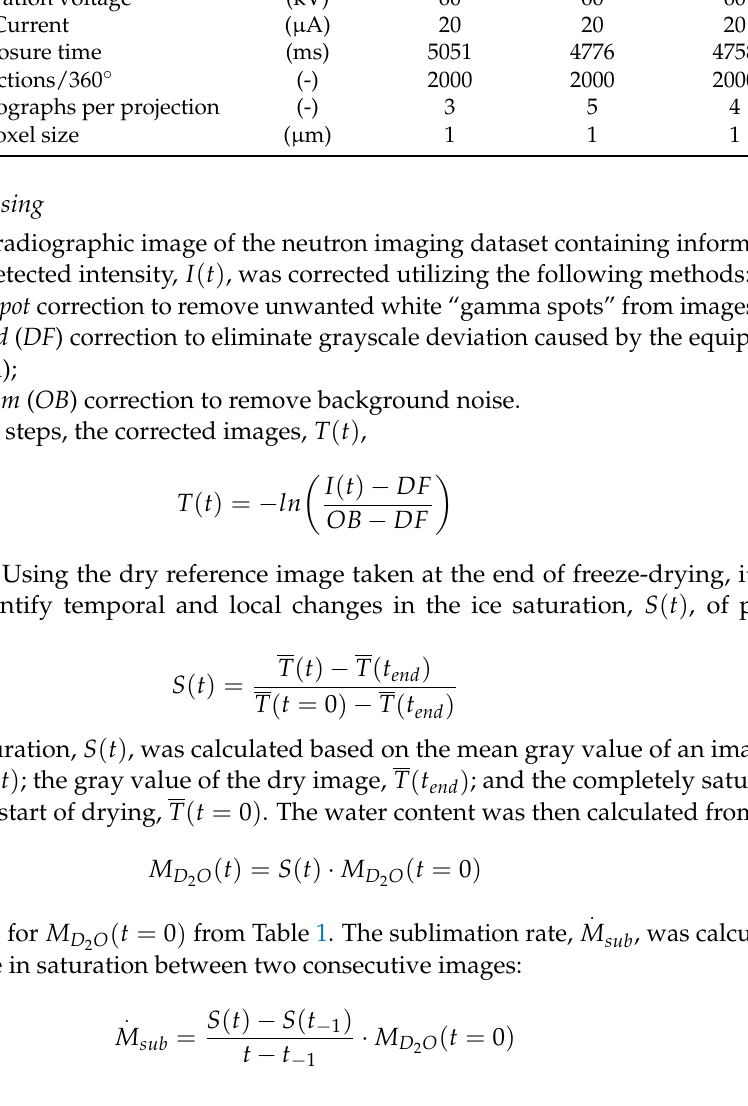
Table 3. X-ray tomography imaging parameters for reference samples dried using the same parame- ters outside the neutron facility. Parameters